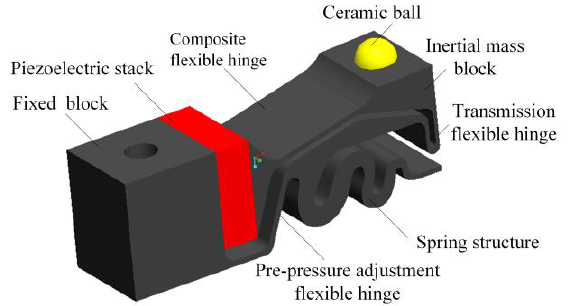
Figure 1. Construction of the piezoelectric actuator.